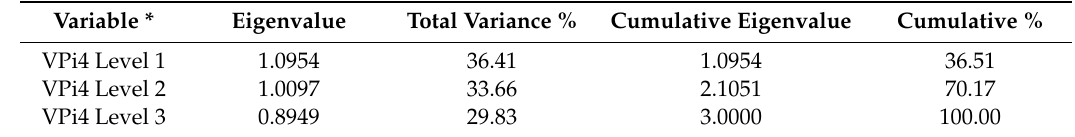
Table 2. Principal Component